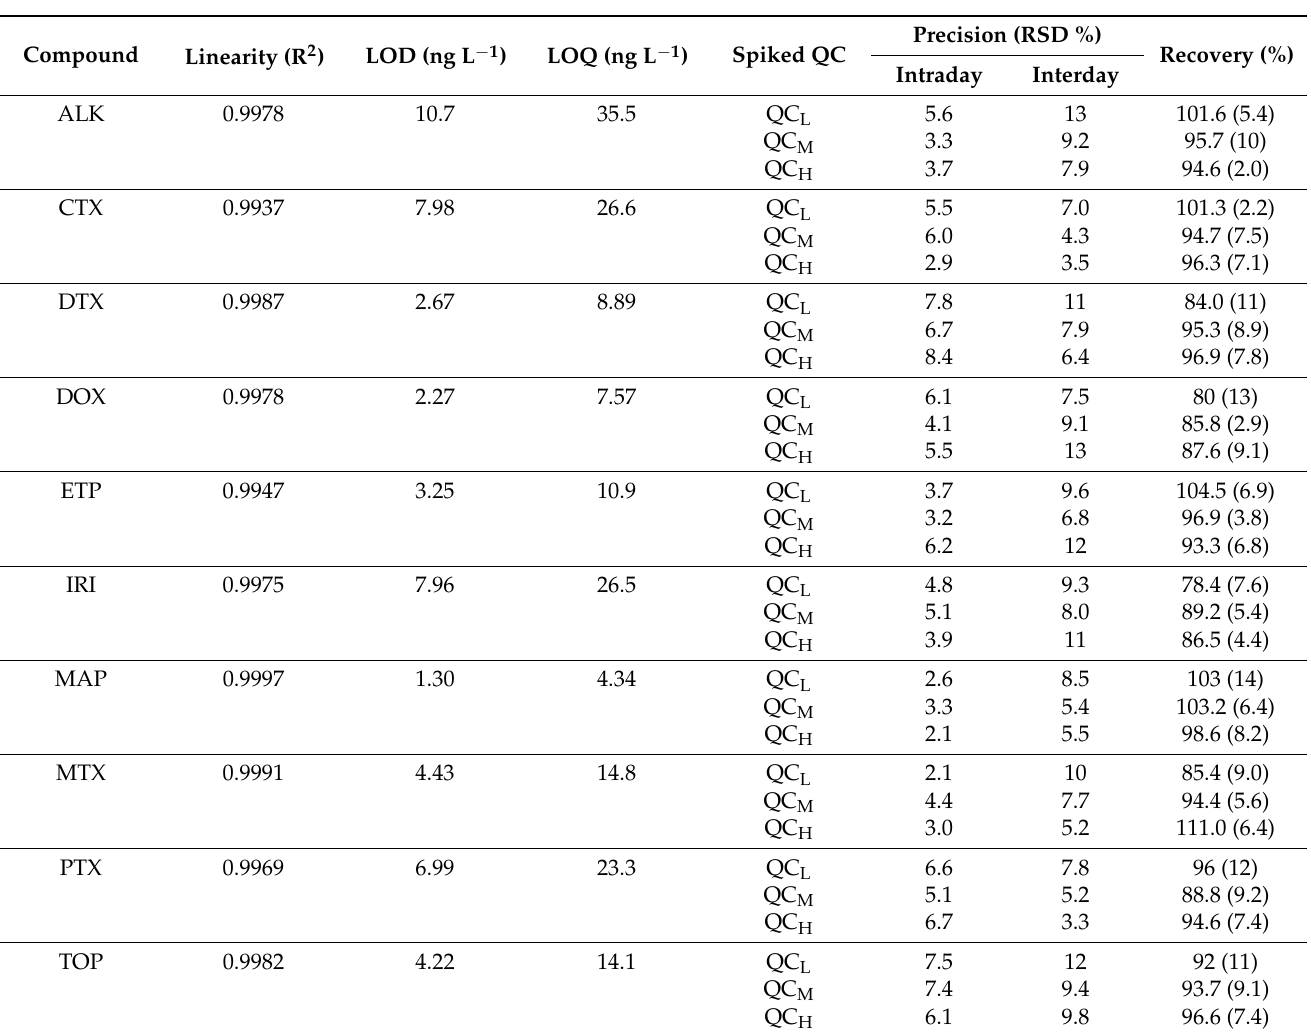
Table 3. Method validation parameters (calibration range, linearity, LOD, LOQ, precision, and recovery). The lowest level of the calibration curve was always the LOQ value. Spiked QC levels for the evaluation of precision and recovery were QC L (LOQ), QC M (100 ng L − 1 ) and QC H (800 ng L − 1 ) for each target compound. RSDs for recoveries shown in